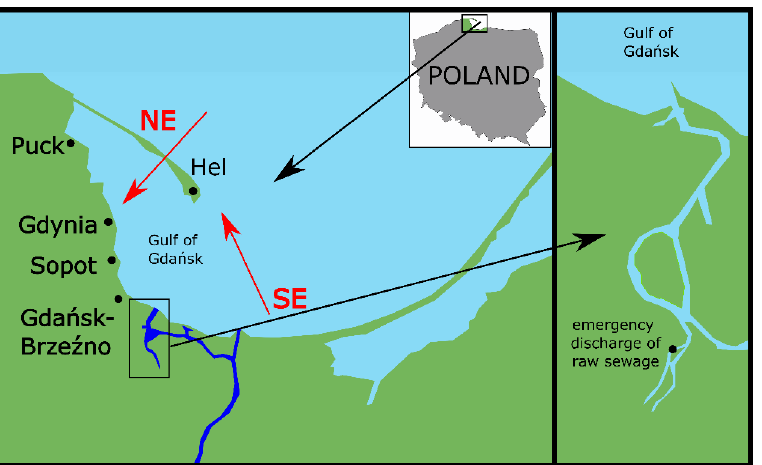
Figure 1. The emergency discharge of raw sewage into the Motława River to the Gulf of Gdańsk in 2018. Map showing the five coastal towns: Hel, Puck, Gdynia, Sopot, and Gdańsk-Brzeźno, where microbiological coastal air were samples collected. The wind direction marked on the map were Southeast (SE) and Northeast (NE) (red arrow). Place of emergency discharge of raw sewage into the Motława River to the Gulf of Gdańsk (black arrow).